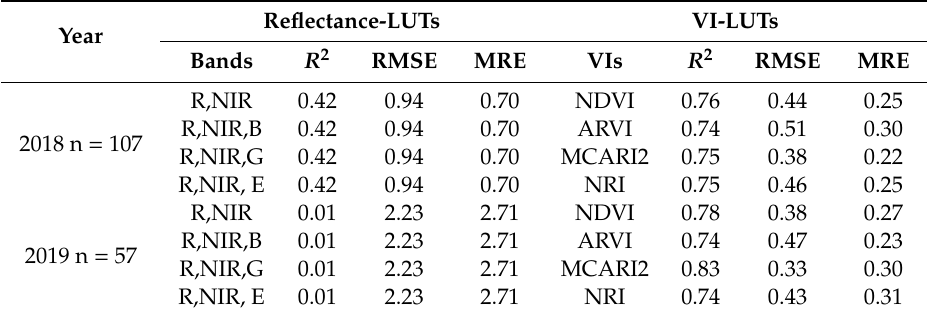
Table 9. R 2 , RMSE, and MRE for linear regression between measured LAI and simulated LAI based on reflectance-LUTs / VI-LUTs using multispectral UAV data. Reflectance-LUTs Year